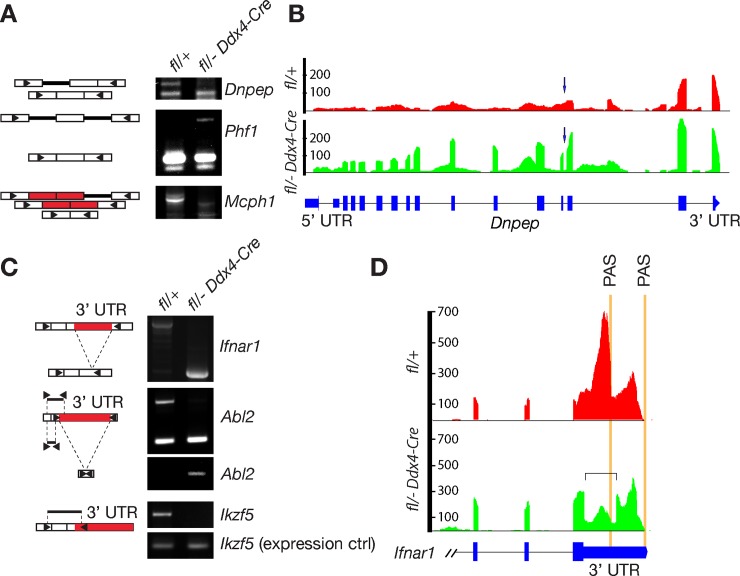
Local splicing variants involve intron retention and 3’ UTR.Oocytes were collected from 6-week-old Ythdc1fl/+ and Ythdc1fl/-
Ddx4-Cre females. (A) PCR validation of intron-retaining LSVs. Introns and exons are represented as thick lines and rectangles, respectively. (B) Gene track view of a retained intron in the Dnpep Gene. Arrow indicates the affected intron. (C) PCR validation of LSVs in 3’ UTRs. The affected portion of the respective 3’ UTR is shown in red. Triangles denote the positions of PCR primers (A and C). (D) Gene track view of splicing variant in the Ifnar1 3’ UTR. The square bracket demarcates the spliced region of 3’ UTR in Ythdc1-deficient oocytes. Polyadenylation sites (PAS) are marked by vertical orange lines.